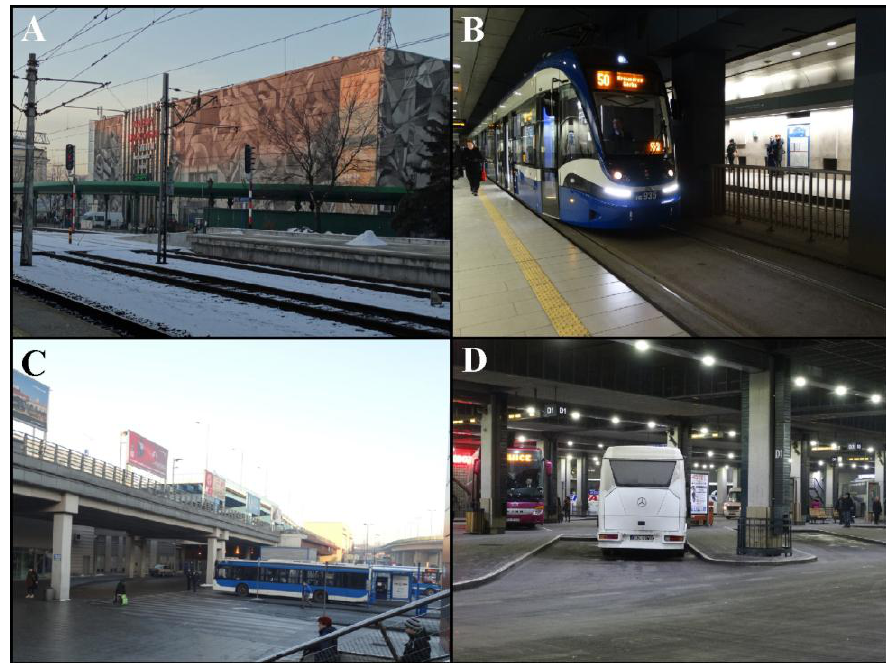
Fig. 9. Galeria Krakowska (A), Cracow Fast Tram Stop (B), public transport bus stops (C) and the lower platform of the Malopolski Bus Station (D) in